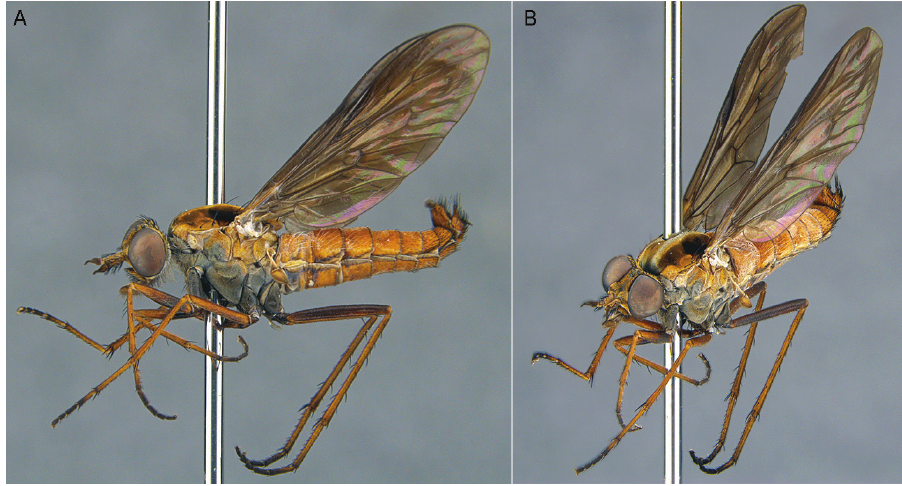
Figure 5. Sidarena aurantia sp. n.: A Male lateral view B same, oblique view.